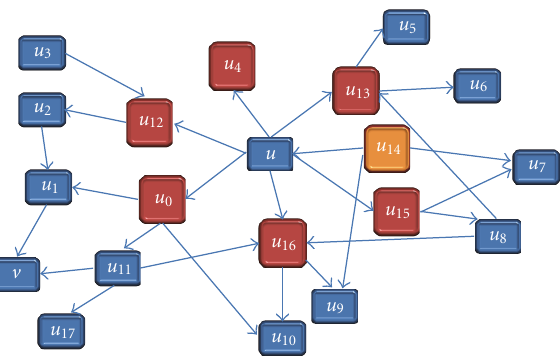
figure and the servers acting as certification authorities